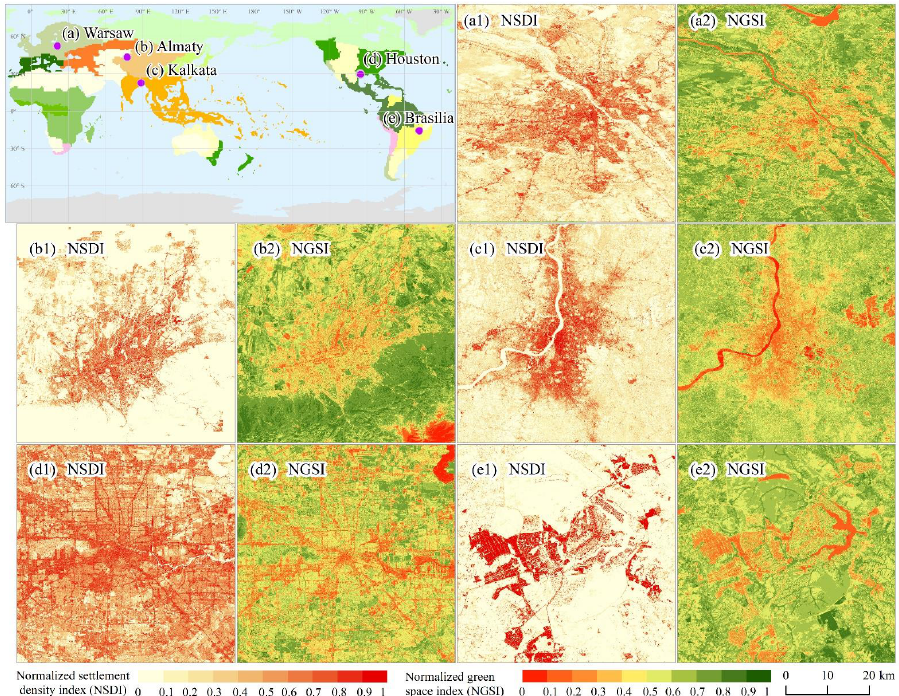
Figure 5. Examples of spatial distribution of NSDI and NGSI in selected regions circa 2020. ( a1 ), ( b1 ), ( c1 ), ( d1 ) and ( e1 ) show the NSDI in selected regions; ( a 2 ), ( b2 ), ( c2 ), ( d2 ) and ( e2 ) show the NGSI in selected regions.